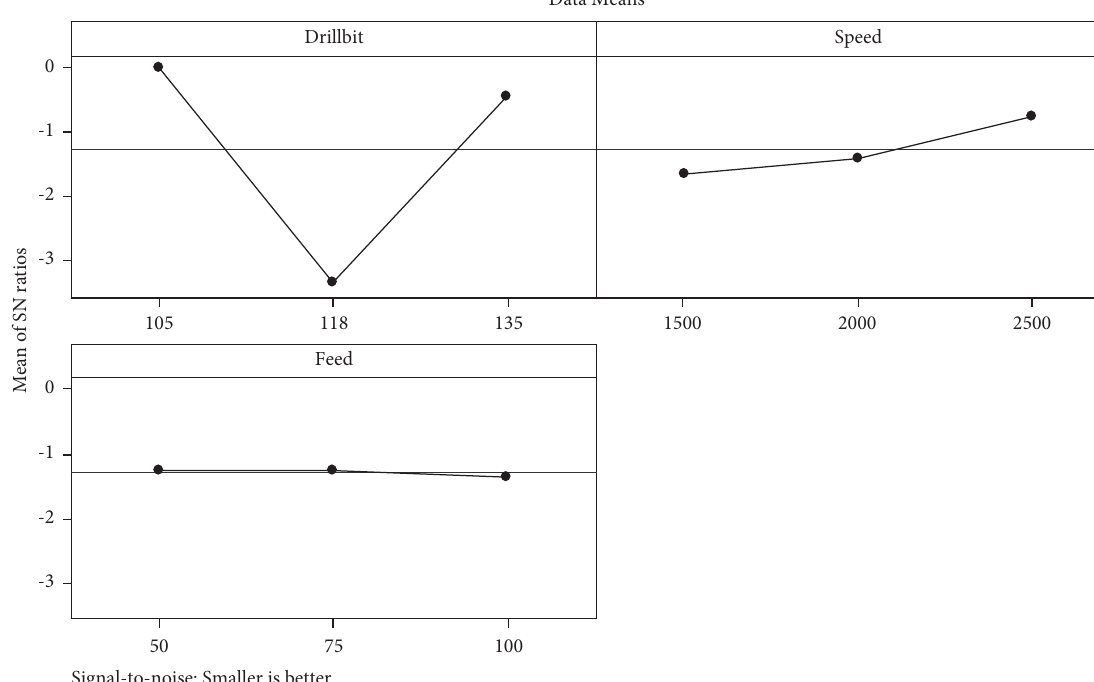
Figure 7: Plot of SN ratios’ key efects-push down